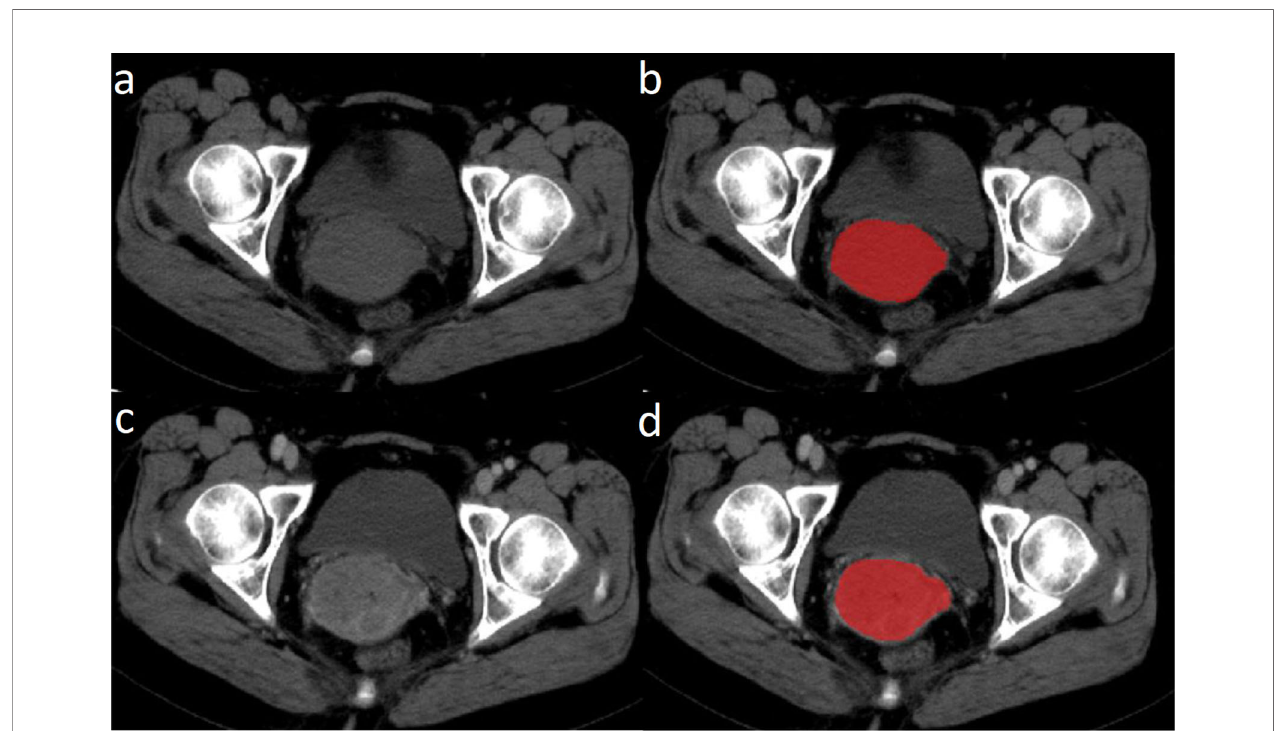
FIGURE 2 | Illustration of tumor segmentation on the maximum level of tumor. (A) Raw pre-contrast image; (B) pre-contrast image after delineation; (C) raw post- contrast image; and (D) post-contrast image after